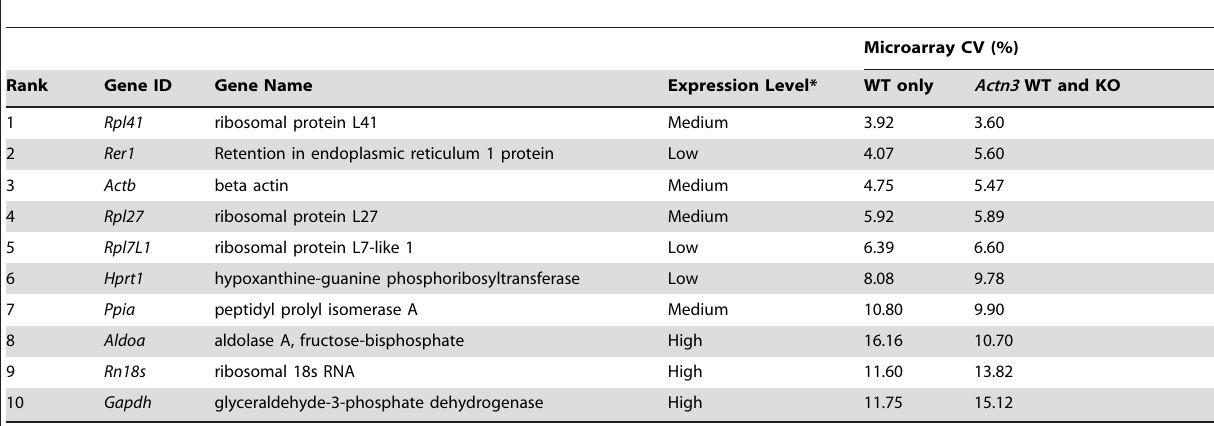
Table 1. Reference genes selected for this study based on % CV from microarray